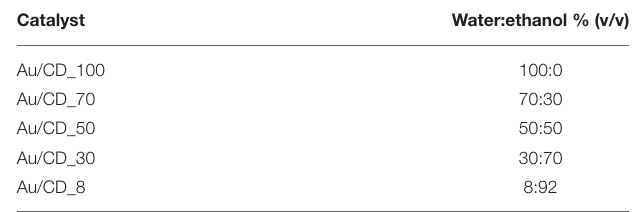
TABLE 1 | Catalyst nomenclature and solvent mixture used in the synthesis.